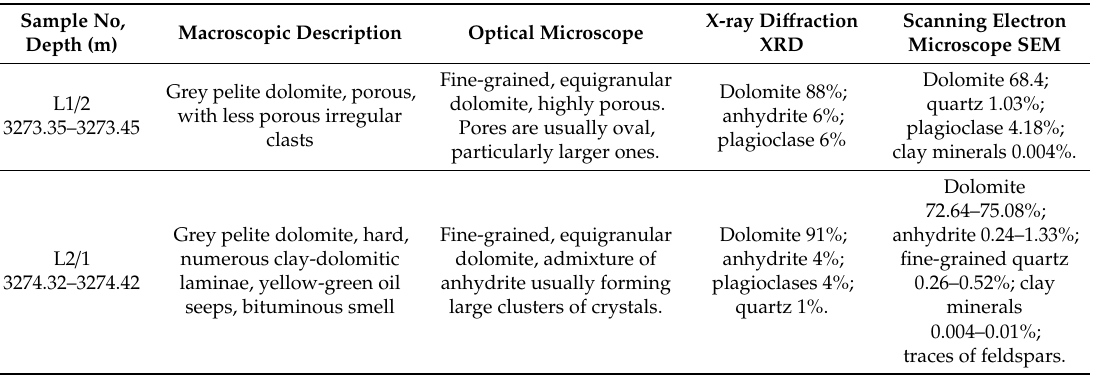
Table 2. The characteristics of rock samples from the Well 1, Well 2 and Well 2k